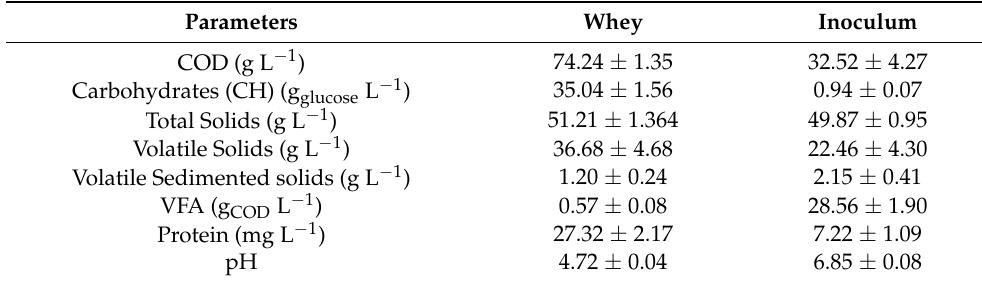
Table 1. Characterization of whey and